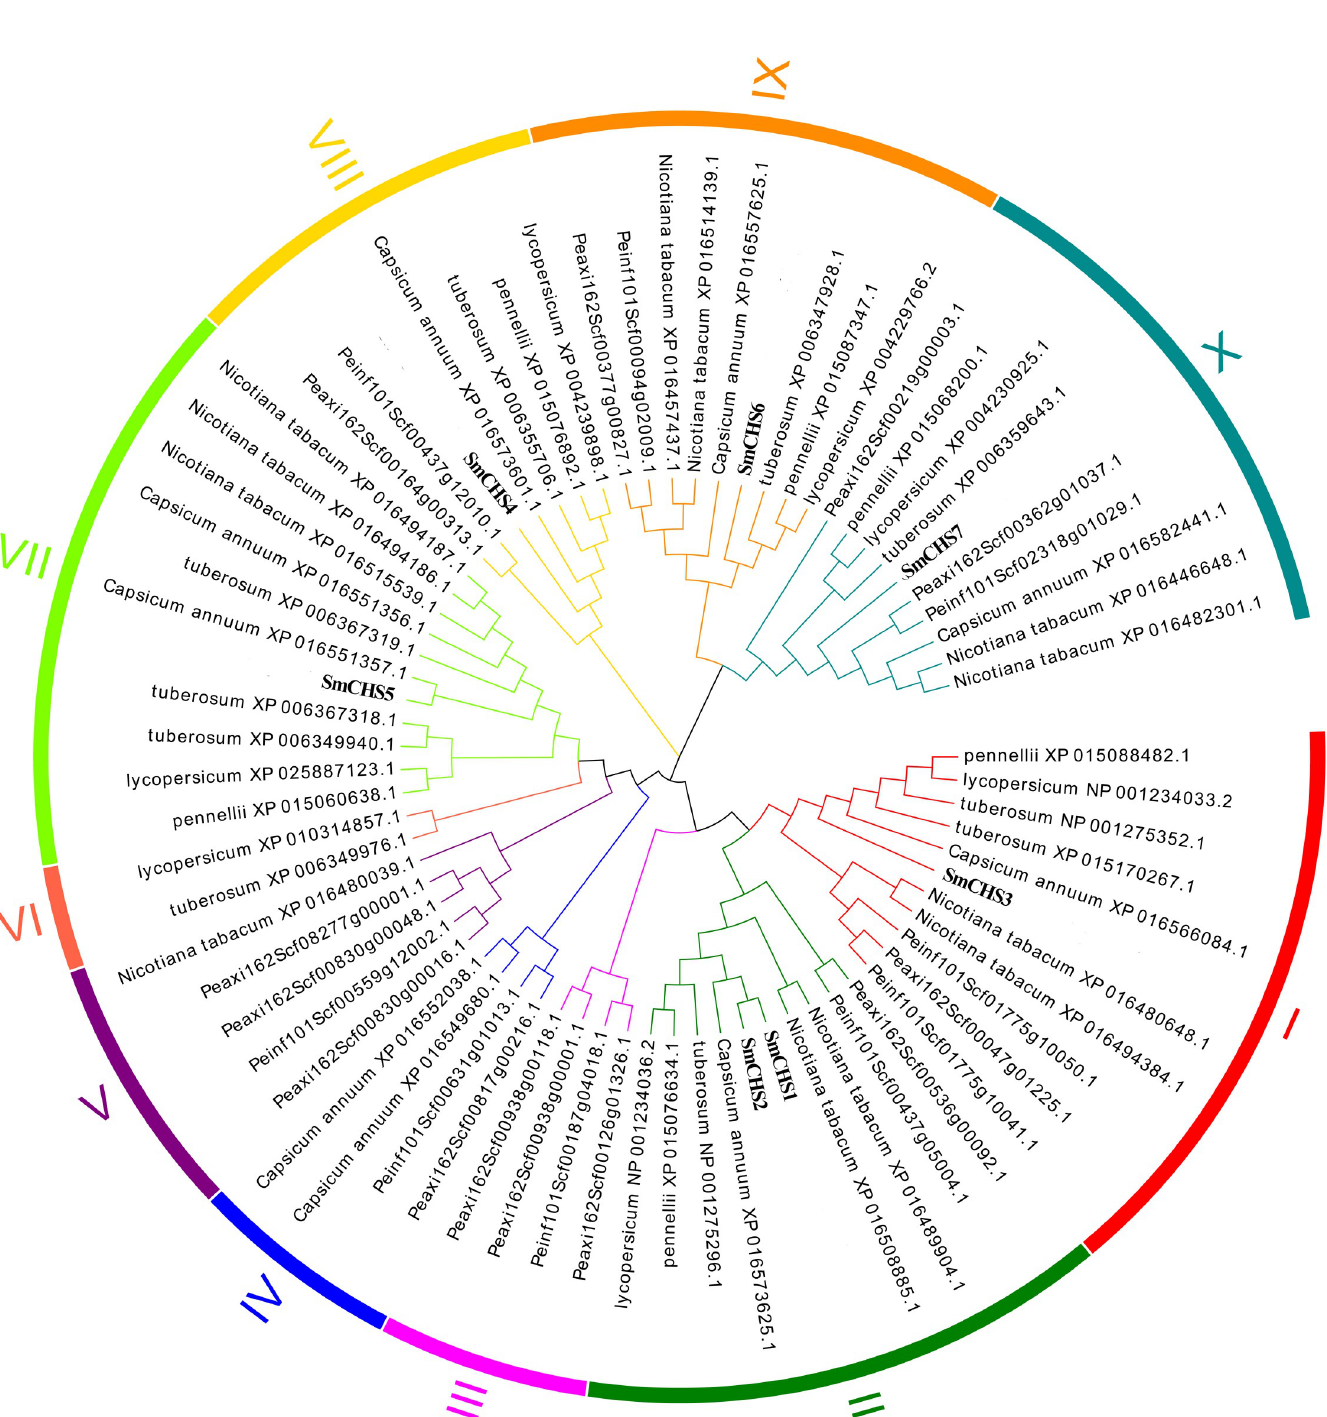
Fig 3. Cis -elements in CHS family gene promoters. (A) Frequency of cis-element occurrence in upstream sequences. (B) Predicted cis -elements in CHS gene promoters. The scale bar indicates the length of promoters.